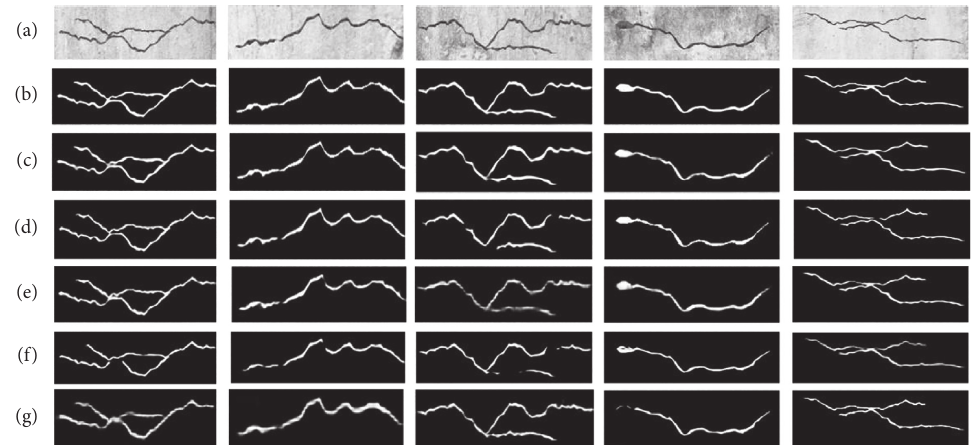
Figure 10: Saliency maps under different loss functions. (a) Image. (b) Ground truth. (c) l . (d) l